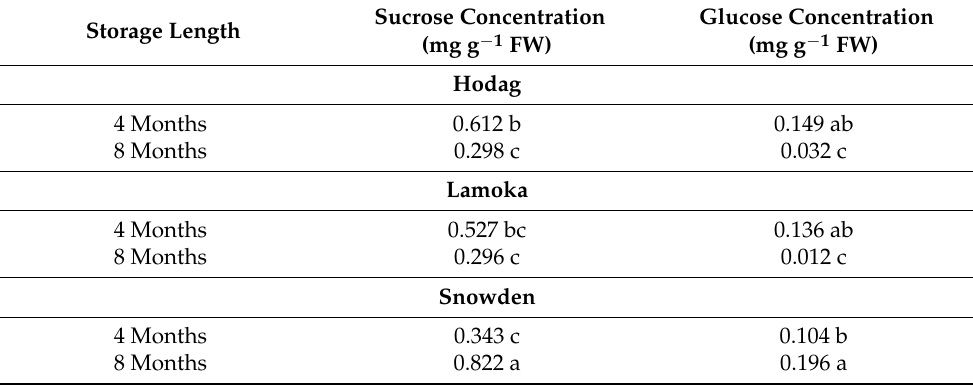
Table 9. Sucrose and glucose concentrations in 2019 significantly affected by the interaction between variety and storage length. Within each sugar type, numbers followed by different letters are significantly different at α = 0.05.